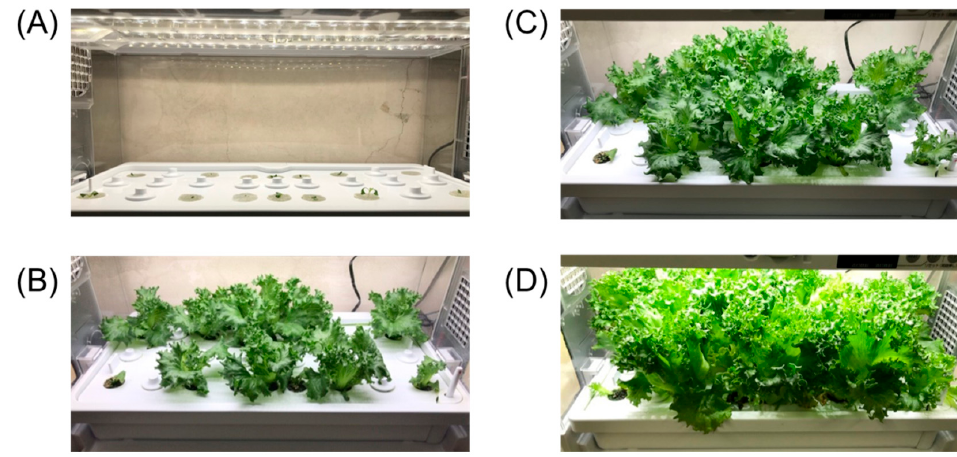
Figure 4. Photo depicting the hydroponic cultivation period for Lactuca sativa : ( A ) day 4, ( B ) day 14, ( C ) day 21, and ( D ) day 28.